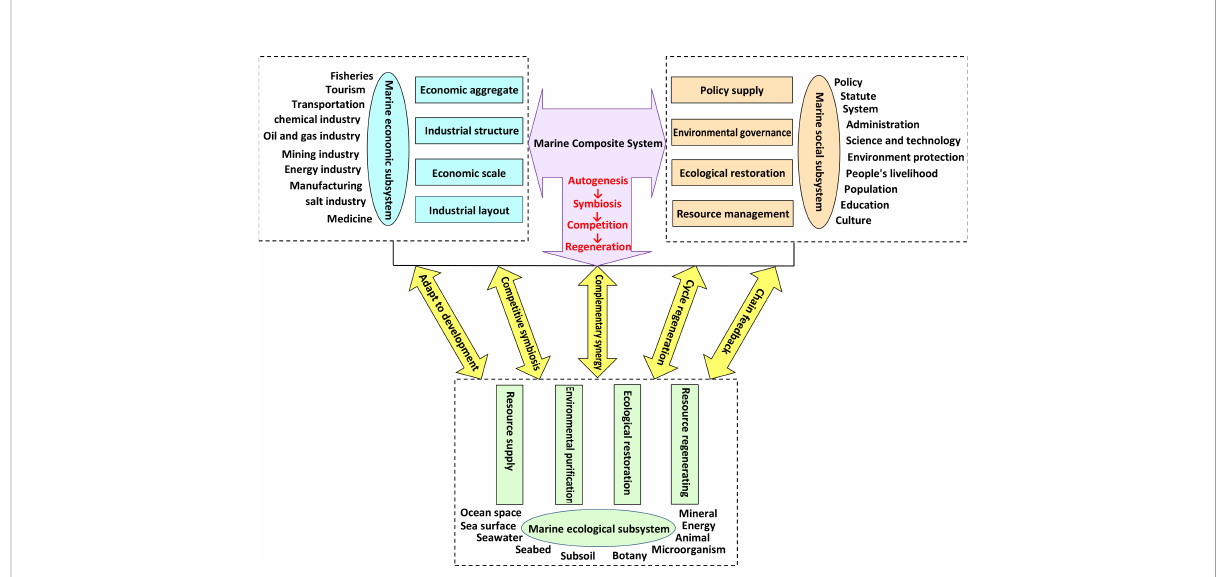
FIGURE 1 Conjugate mechanism model of subsystem of Marine Composite